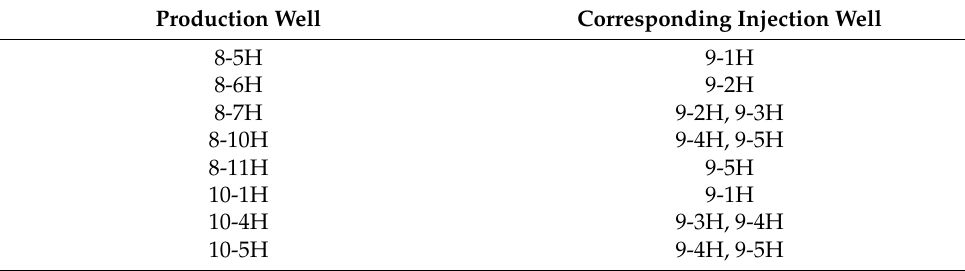
Table 2. Table of injection-production relationship of horizontal well pattern.